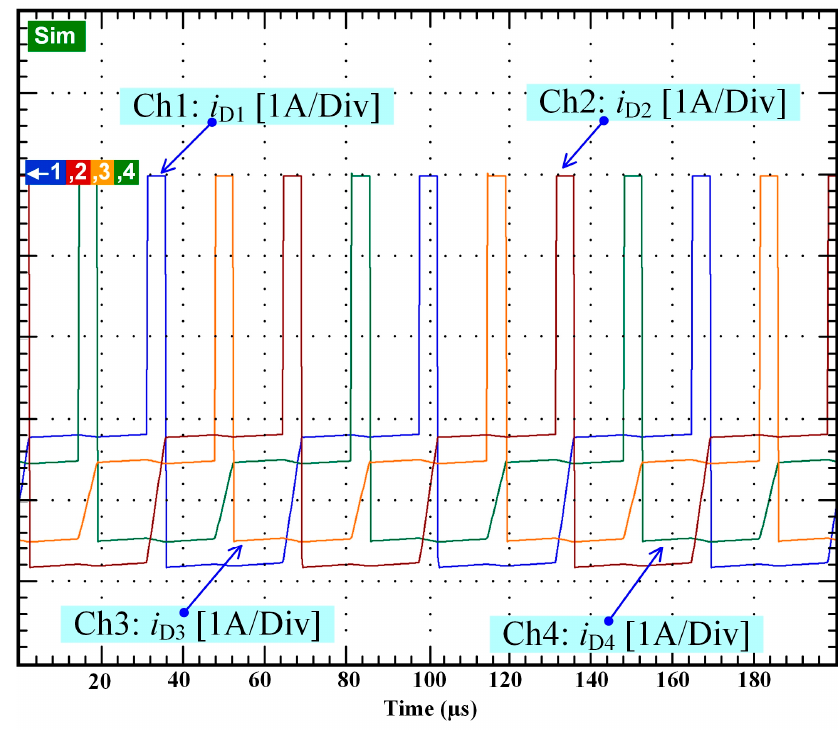
Figure 17. Simulation results: free-wheel diode currents in healthy mode.